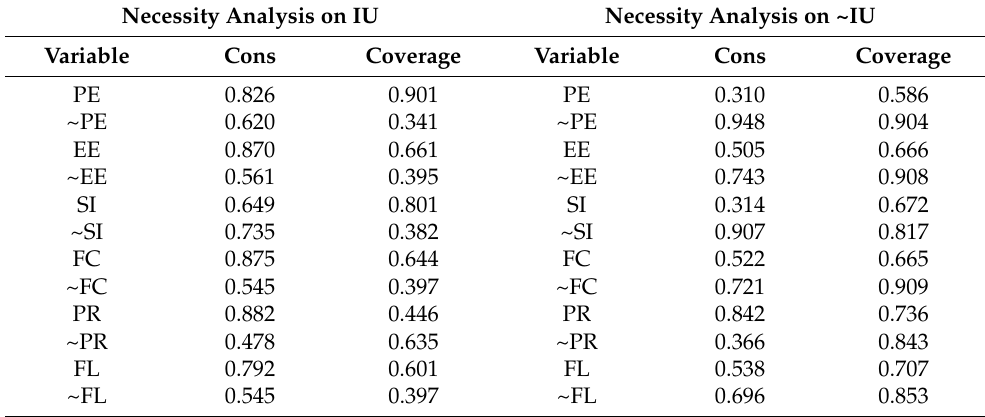
Table 3. Necessity analysis on IU and